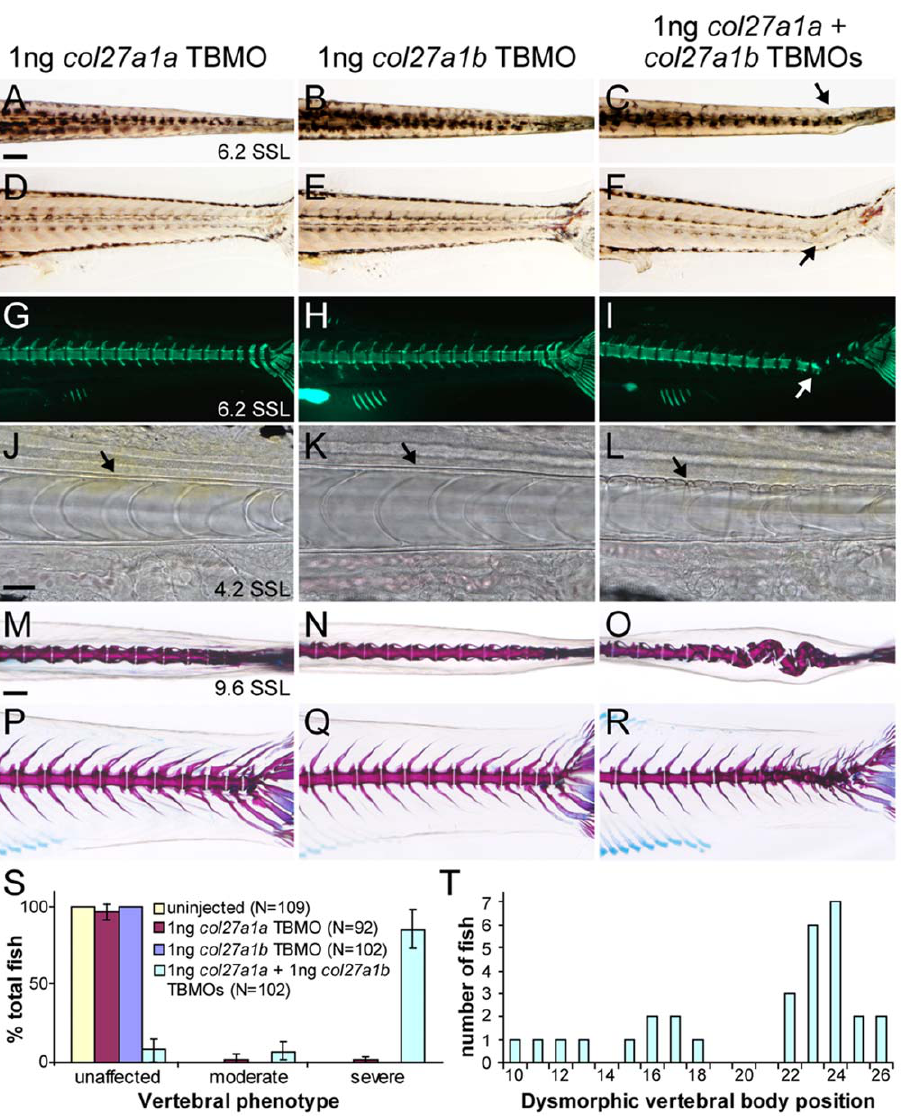
Figure 7. col27a1a and col27a1b interact genetically in the notochord and axial skeleton. Injection of col27a1a TBMO (A, D, G) and col27a1b TBMO (B, E, H) at low dosage did not result in a phenotype as seen at , 6.2 SSL (14 dpf). (C, F) Simultaneous injection of col27a1a and col27a1b TBMOs at low dosage, however, resulted in notochord curves (black and white arrows). (I) Calcein staining to visualize mineral showed abnormal mineralization in double morphants. Brightfield analysis of col27a1a (J), col27a1b (K) and col27a1a and col27a1b double morphant (L) notochords at , 4.2 SSL (8 dpf) showed severe buckling of the notochord sheath (black arrow) in double morphants. Dorsal and lateral views of col27a1a (M, P), col27a1b (N, Q) and double morphants (O, R) at , 9.6–10 SSL (21 dpf) showed formation of scoliotic curves in the vertebral column of double morphants. (S) By , 9.6–10 SSL, 92% of col27a1a and col27a1b double morphants had developed either moderate or severe vertebral defects, with the majority being very severe. The mean from 3 clutches 6 standard error is shown. (T) Dysmorphic vertebrae without hemal or neural spines were also observed in double morphants. These additional dysmorphic vertebrae were spread throughout the vertebral column but preferentially localized to a region near the distal end of the tail. Scale bars in A and M represent 200 m m and apply to B–I and N–R, respectively. Scale bar in J represents 20 m m and applies to K and L.